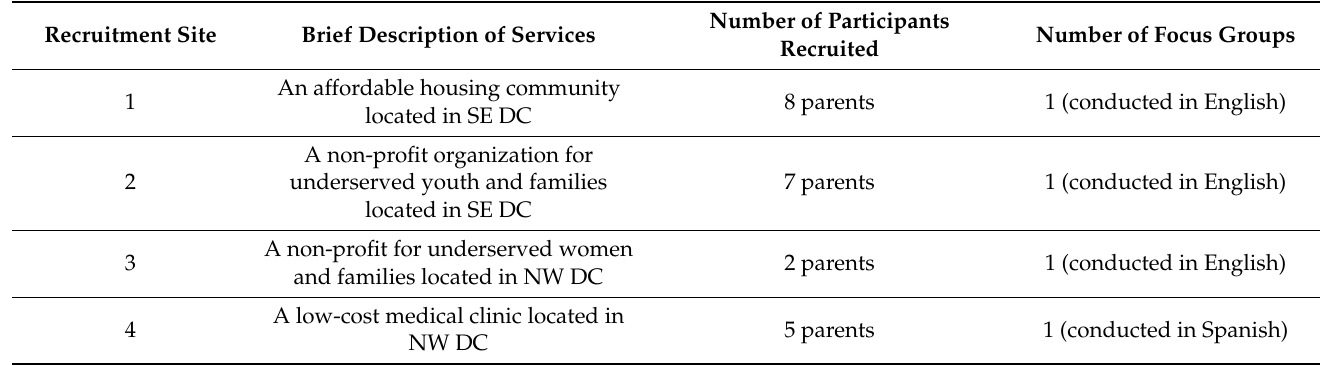
Table 2. Overview of recruitment sites and participants